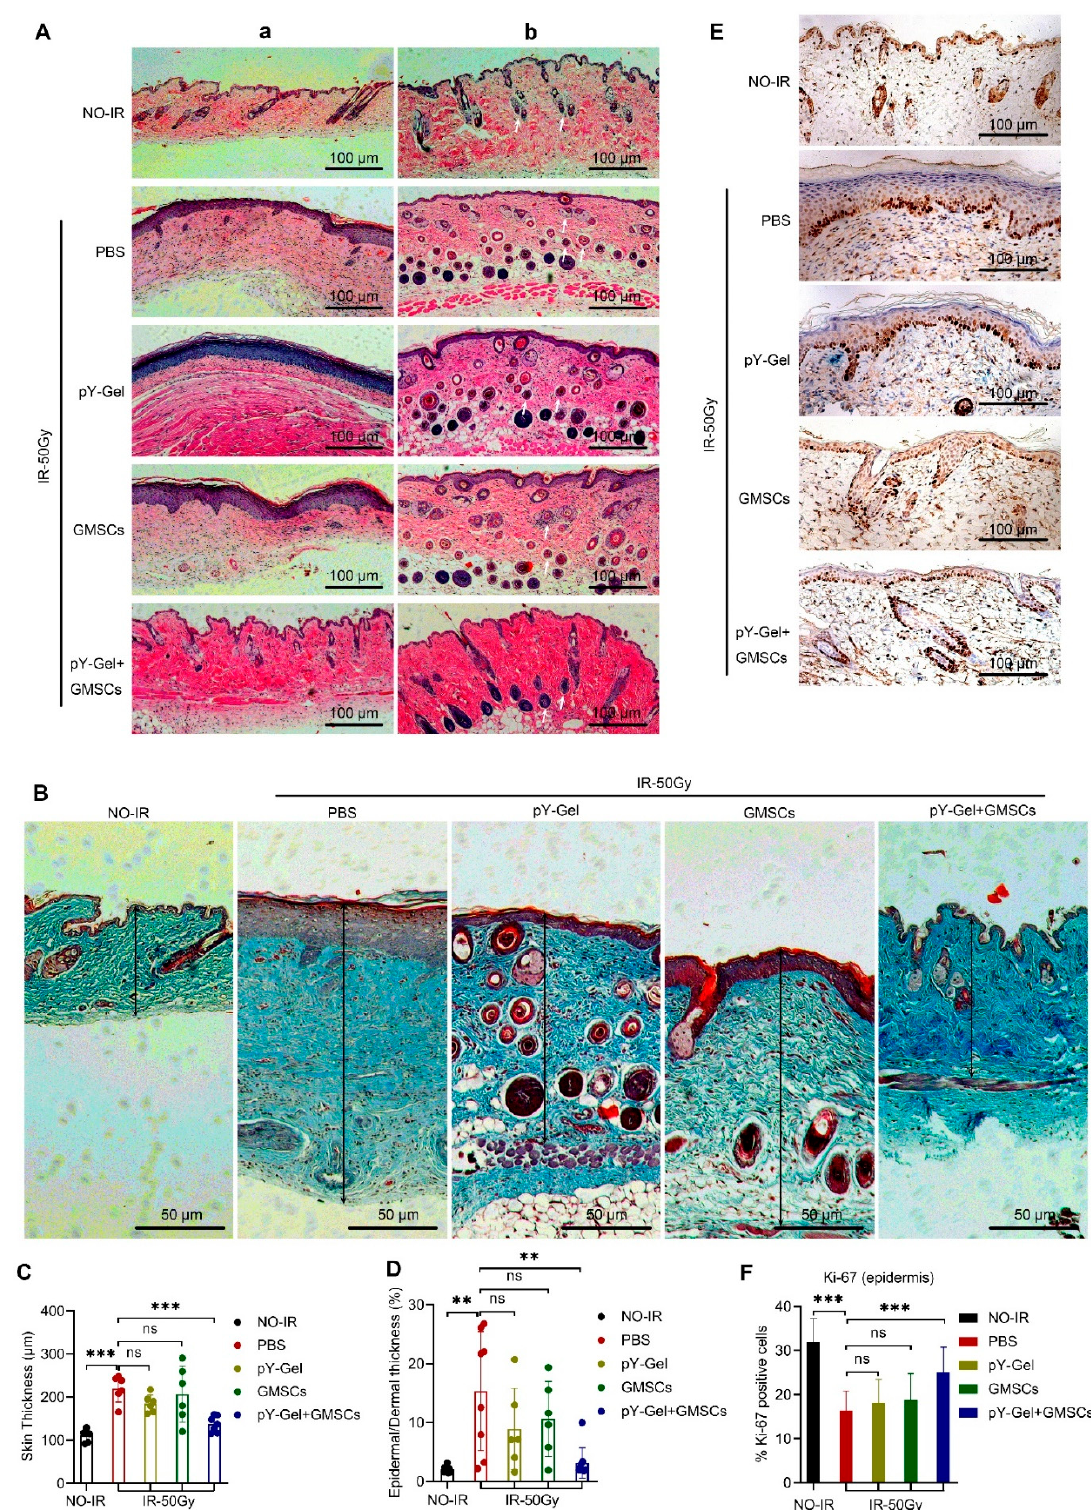
Figure 2. Evaluation of the healing quality of CRI. ( A ) H&E staining images of limb lesions in mice with radiation injury at 30 days post-treatment. The white arrows point to the sebaceous glands in the dermis. ( B ) Masson’s trichrome staining of wound sections. The black arrows indicate the skin thickness. ( C , D ) Skin thickness is measured from the dermal–subcutaneous interface to the outer surface of the epidermis and the ratio of epidermis/dermis. ( E , F ) Representative immunohistochemical images and quantitation of Ki67 in skin epidermis from non-irradiated